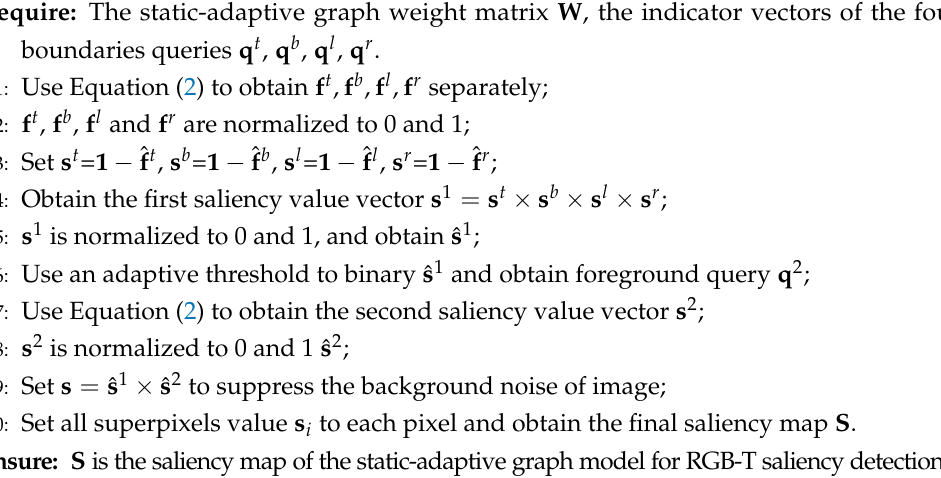
Algorithm 1 The Static-Adaptive Graph based RGB-T Salient Detection